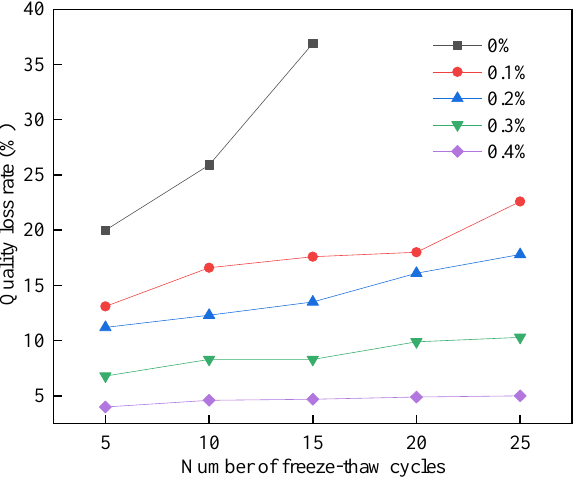
Figure 25. Mass loss rate of freeze – thaw cycle test.